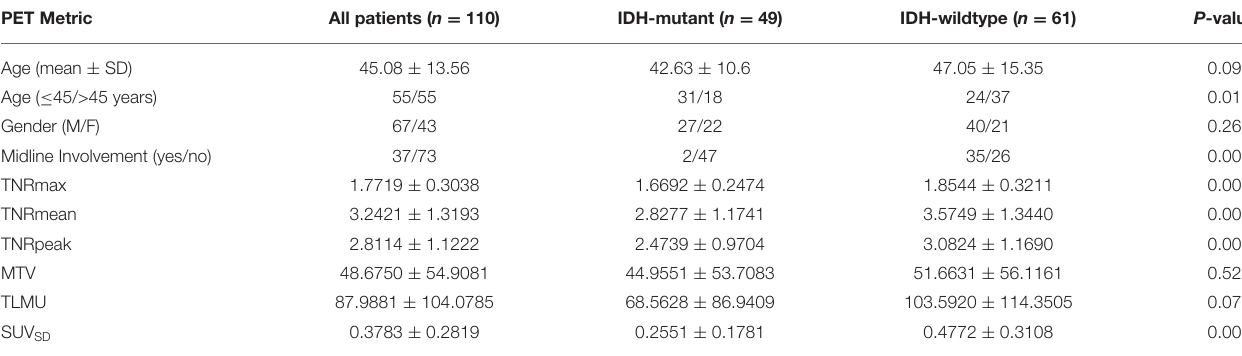
a comparison between IDH-mutant and IDH-wildtype.